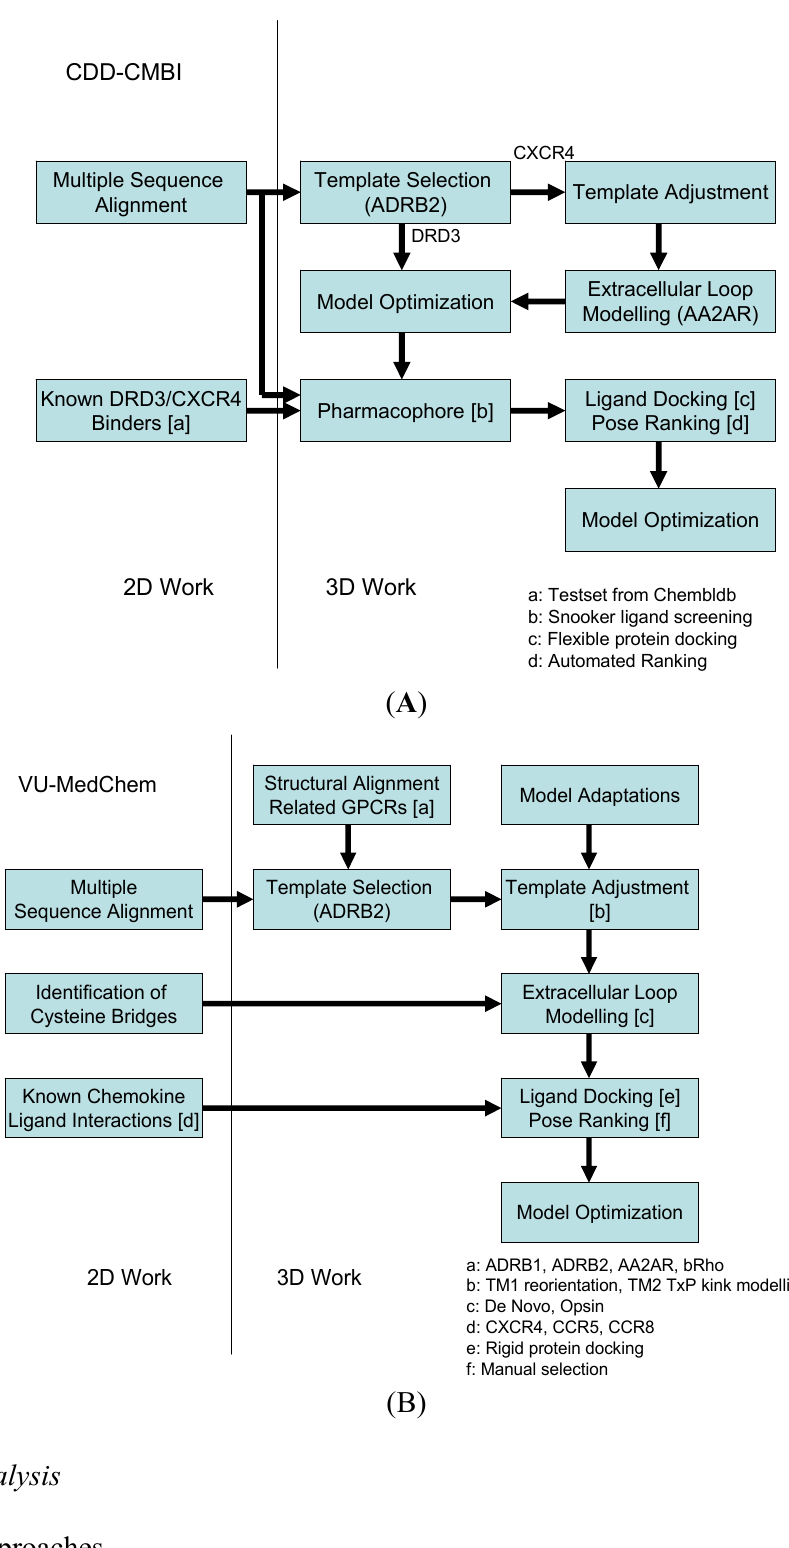
Figure 2. Modeling workflows as used by ( A ) the CDD-CMBI group; and ( B ) the VU-MedChem group in the GPCR Dock 2010